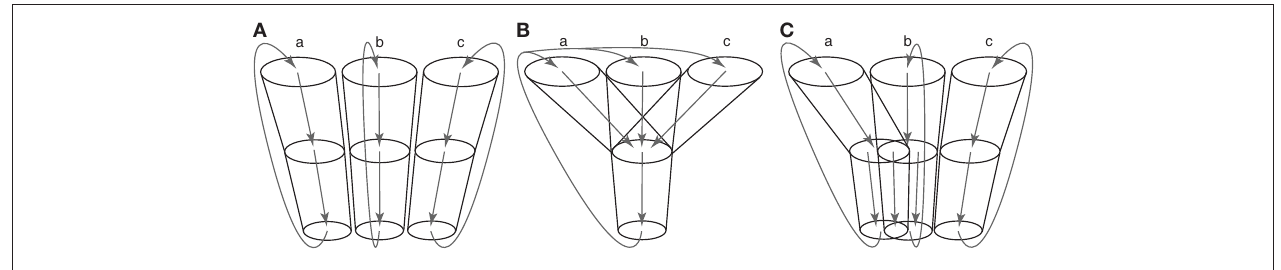
hypothesis. Information originating from different cortical areas converges and is integrated in the basal ganglia, and integrated information returns to all the cortical areas. (C) Intermediate hypothesis between parallel processing and information convergence hypotheses, which is supported by